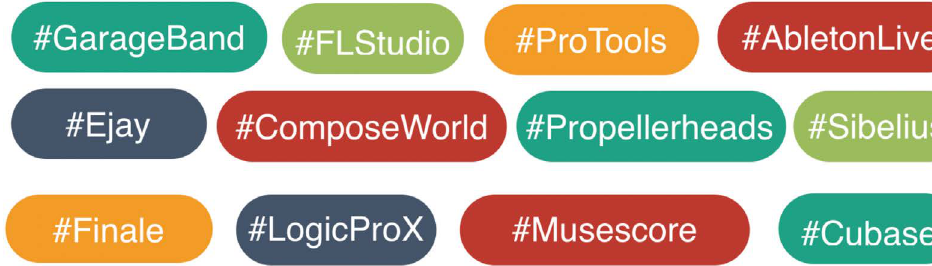
Figure 3. Example of musical software available for education. Source: